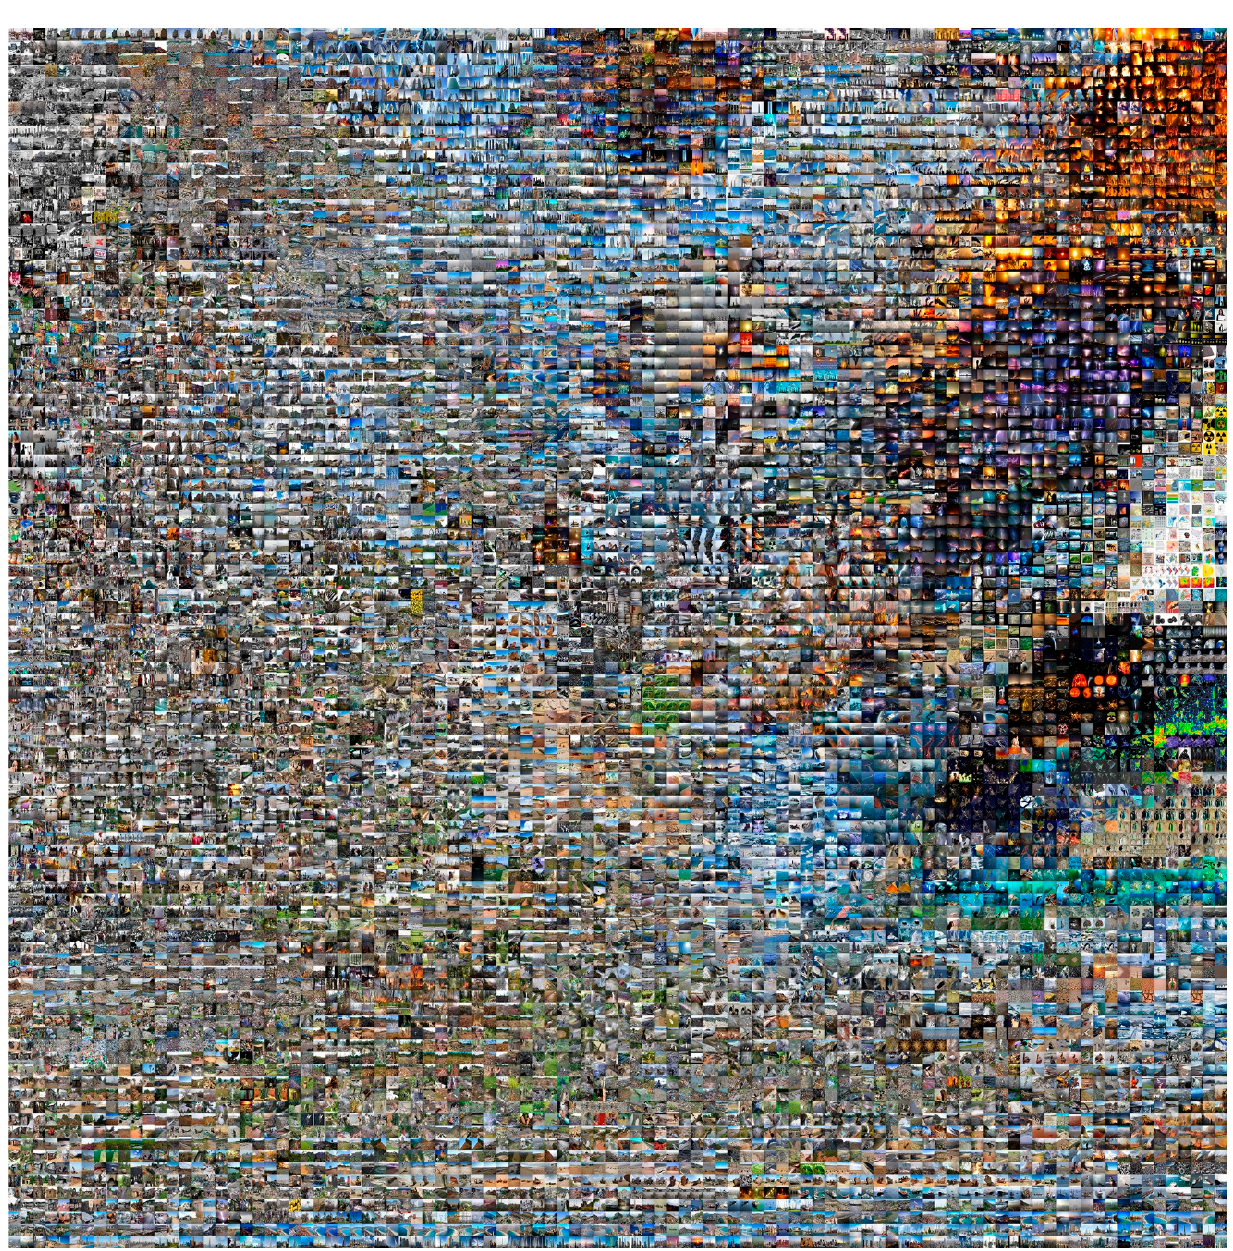
Figure 18 . Digital image containing 10,000 photographs concerning climate change, ordered using the ResNet-50 convolutional neural network (2 × 2 m). © Pilar Rosado.